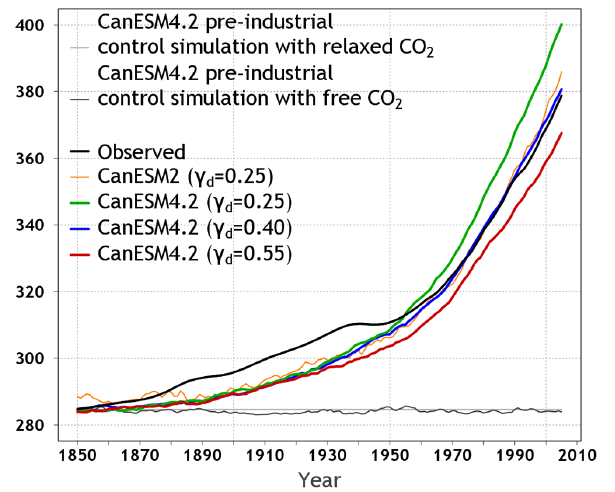
Figure 7. Simulated globally averaged surface atmospheric CO 2 concentration from CanESM2 and the three CanESM4.2 histor- ical 1850–2005 simulations with different strengths of the ter- restrial CO 2 fertilization effect. The observation-based concentra- tion is shown in black. Also shown is the CO 2 concentration of 284.6ppm used in CanESM4.2’s pre-industrial simulation in the relaxed-CO2 configuration and the simulated concentration from the pre-industrial CanESM4.2 simulation with interactively deter- mined CO 2